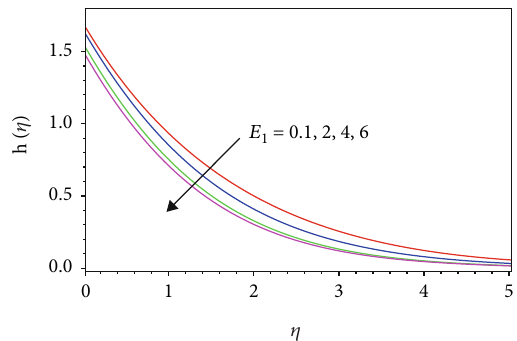
Rc 1 when = 100 . p = f = 0 and 1 w